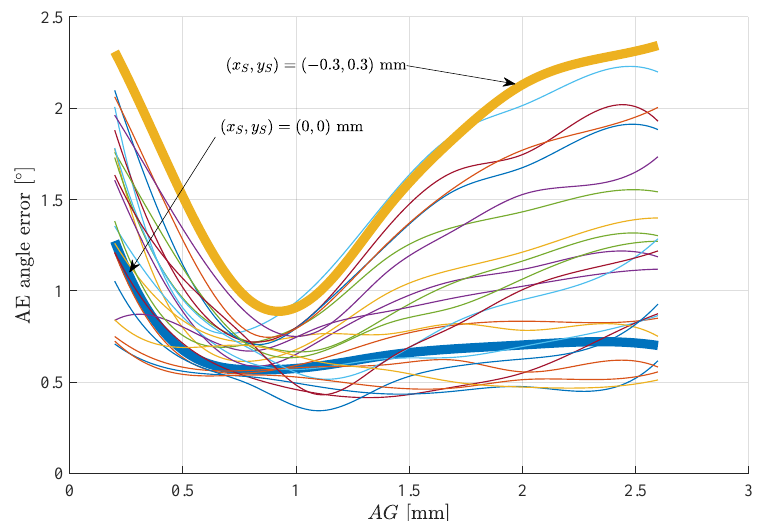
Figure 7. Measured AE angle error vs. AG for a single piece of test chip with RR = 1 mm. Each curve was measured for a specific sensor eccentricity x S , y S in the range of [ − 0.3,0.3 ] mm. All other assembly tolerances were too small to be measured, but it is very likely that they did not vanish altogether (magnet eccentricity < 0.1 mm and tilts up to a few degrees). During the experiment, the sensor was mounted only once on the translation stage, and therefore all assembly tolerances were constant, except for x S and y S . Note that the combined action of inevitable assembly tolerances and intentionally changed sensor eccentricity produces a wide variety of curves that fill up the entire area below the curve with maximum sensor eccentricity. The curve for ( x S , y S ) = ( 0,0 ) mm is flat for medium and large air gap, but it increases at small air gap, which is probably due to inevitable tilt errors. The curve for ( x S , y S ) = ( − 0.3,0.3 ) mm has identical behavior at small air gap; yet, at large air gap, we clearly see the strong effect of eccentricity proportional to the rise in ˜ E axial versus air